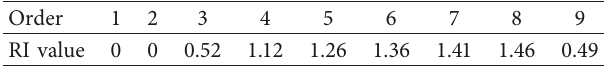
Table 2: The values of RI corresponds to N .